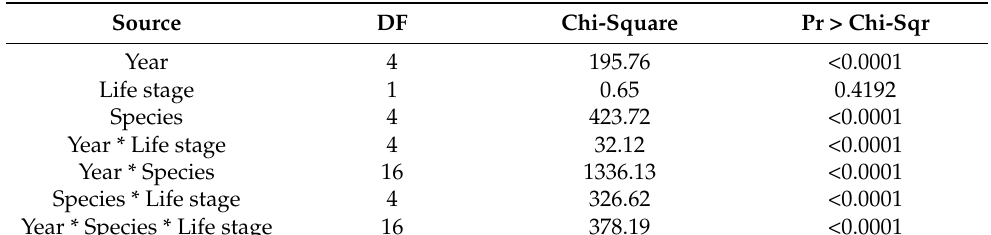
Table 1. Effect of species, life stage, and calendar year on fish abundance from the generalized linear model. Interactions are indicated by a * between main effects.